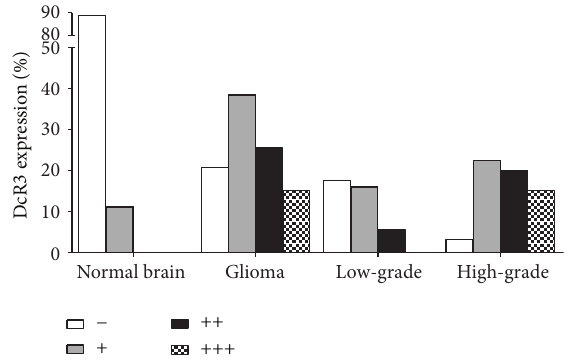
Figure 1: Relationship between DcR3 expression and glioma differ- entiation.